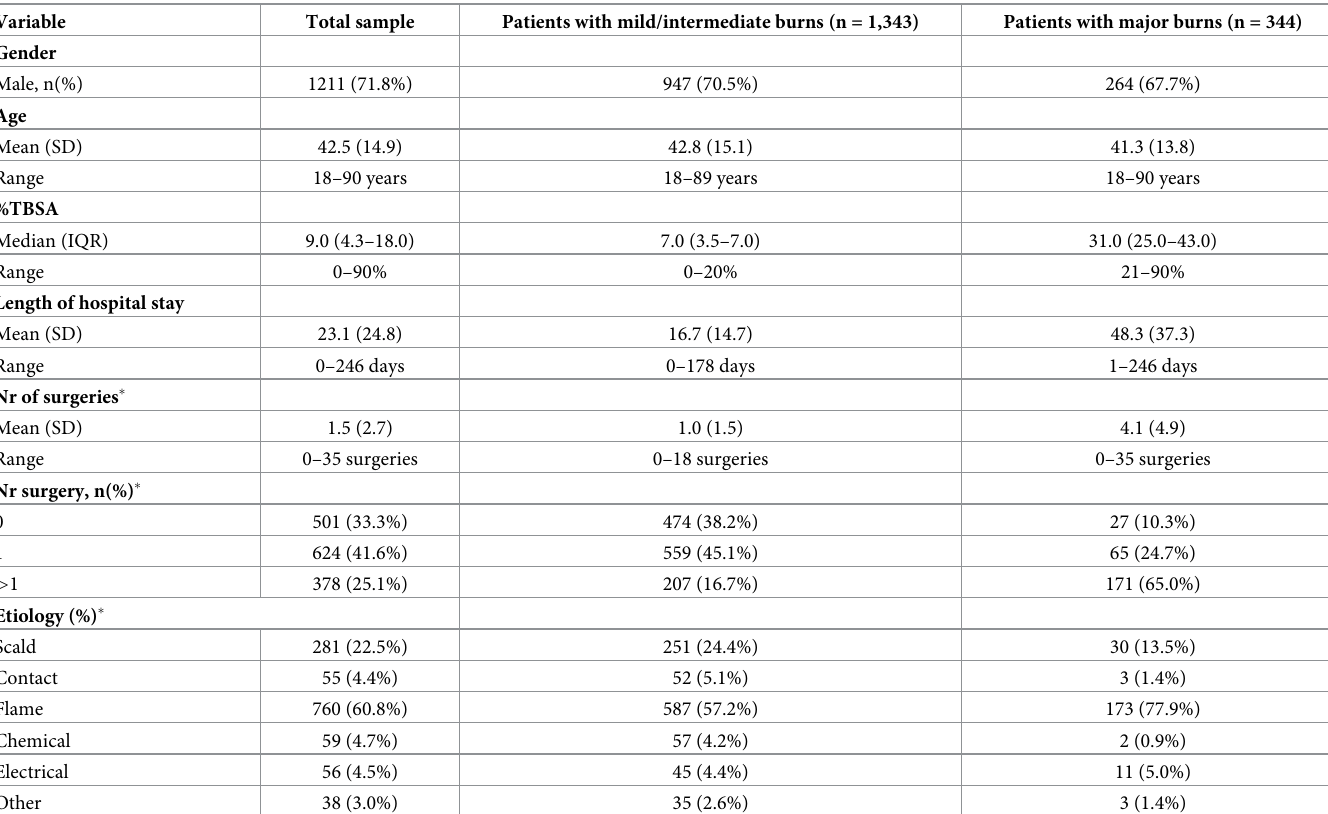
Table 2. Demographic characteristics of combined